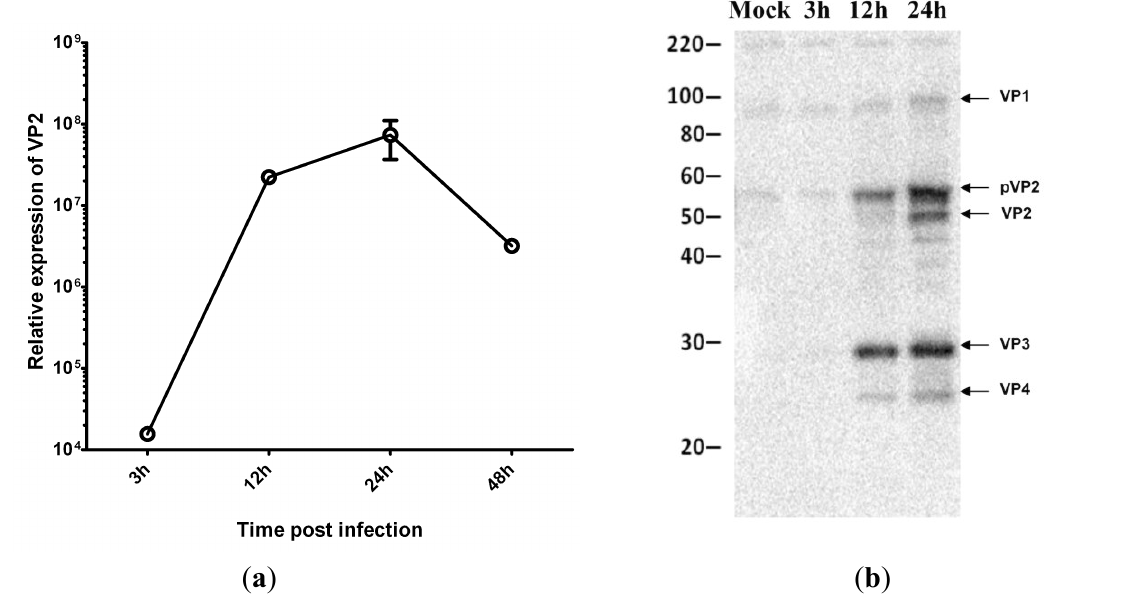
Figure 3. IPNV replication in virus-infected CHSE cells. ( a ) Relative expression of infectious pancreatic necrosis virus mRNA at different time post infection (n=3); ( b ) Western blot analysis for IPNV proteins synthesis at different times post infection.